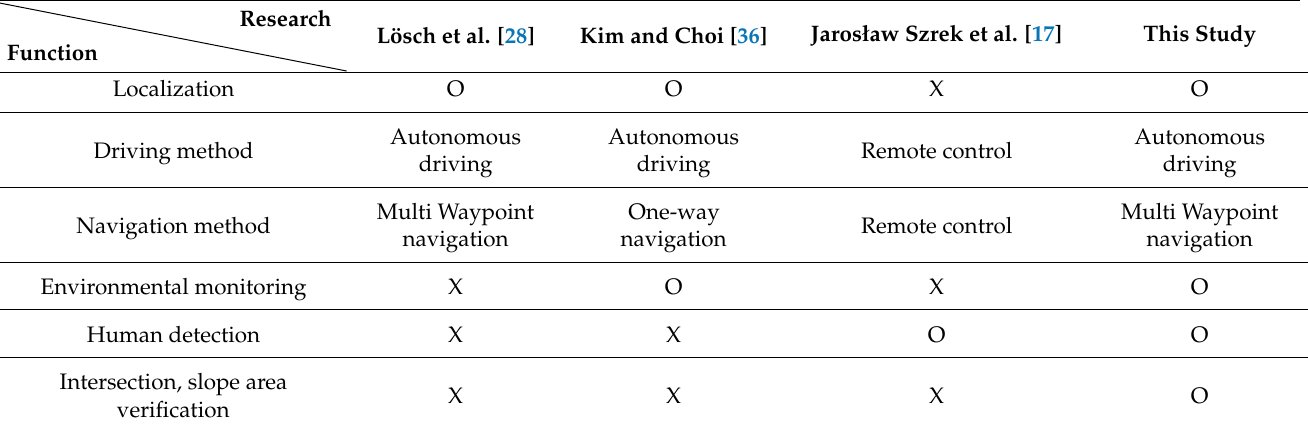
Table 4. Comparison of mobile robot systems developed in this study with those developed in previous